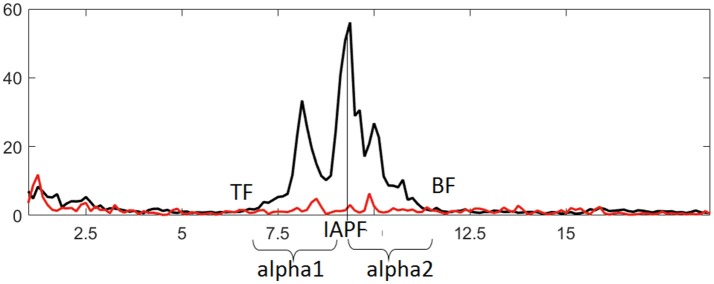
Identifying individual alpha band and derived metrics based on comparing EEG spectral power in eyes closed (black line) and eyes open (red line) conditions. IAPF, TF, and BF represent individual alpha peak frequency, theta and beta transition frequencies, respectively.